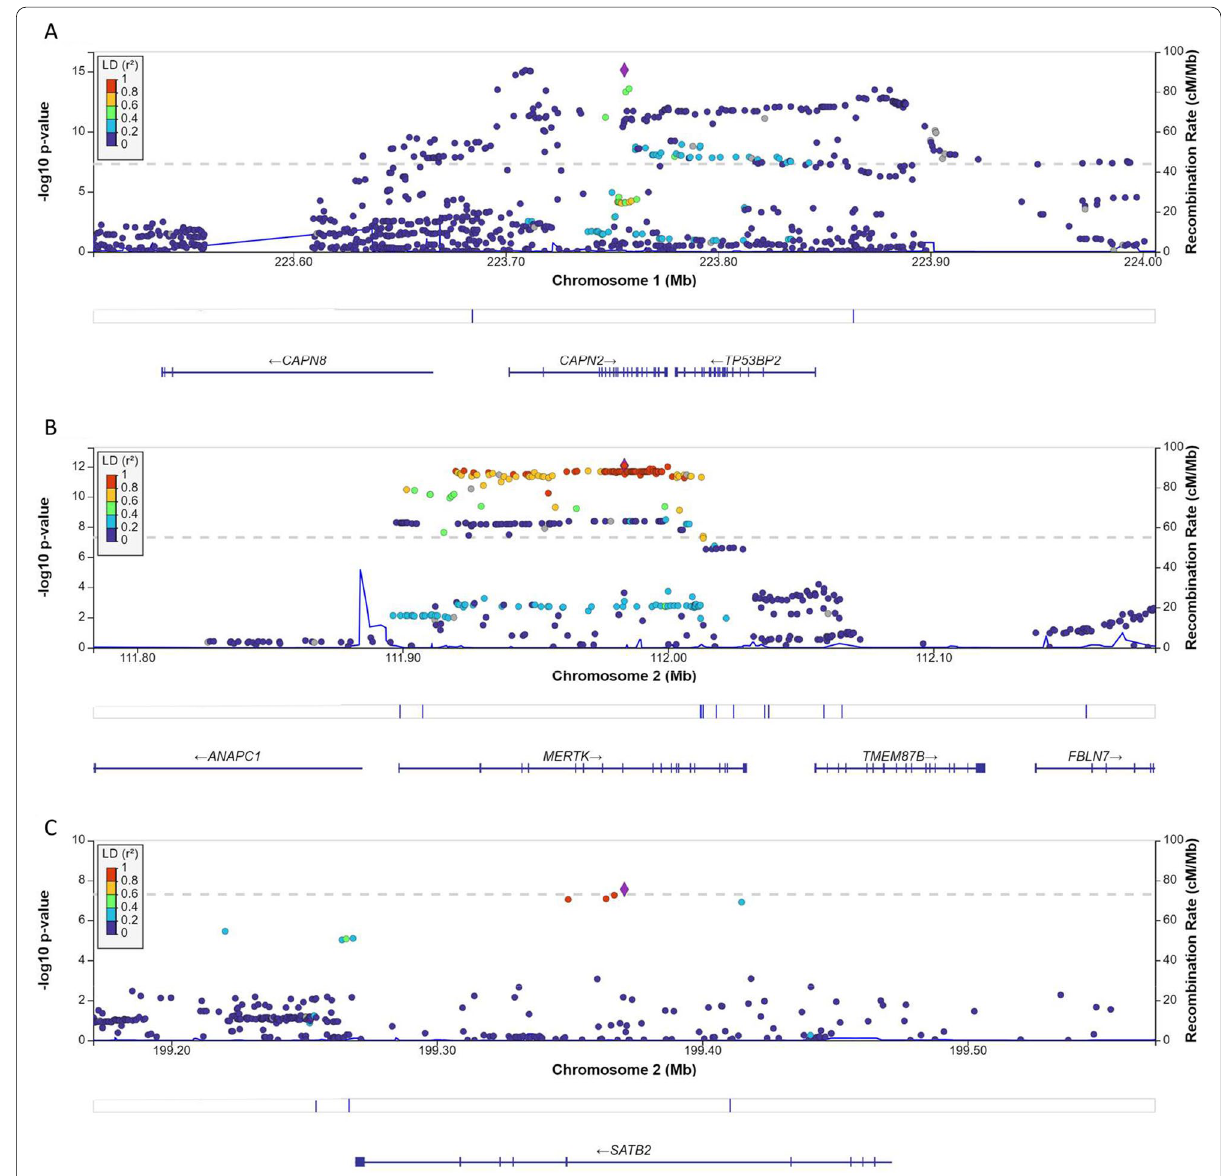
Fig. 2 Regional association plots of the two genome‑wide significant cluster headache loci ( A ) CAPN2 , ( B ) MERTK , and ( C ) SATB2. Each dot represents a single nucleotide polymorphism (SNP) derived from the fine‑mapped imputation data. The horizontal axis gives the genomic coordinate and the vertical axis the significance level (‑log 10 p value). The top SNP for each locus is marked with a purple diamond (CRCh38/hg19). SNPs are colored based on their correlation (r 2 ) with the labeled lead SNP according to the legend. The solid blue line shows the recombination rate from 1000 Genomes EAS data (right vertical axis). The gray dash line corresponds to p